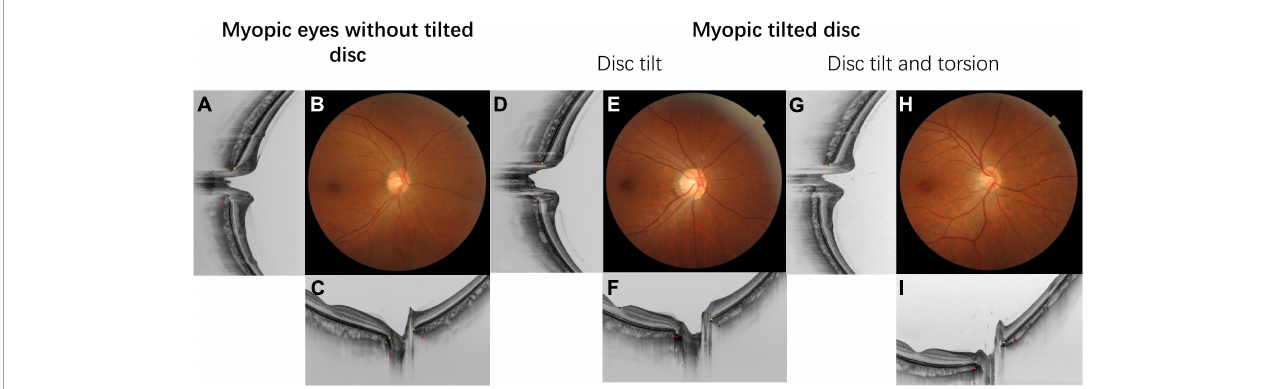
FIGURE1 This figure demonstrated the fundus photograph and its corresponding horizontal and vertical cross-sectional optical coherence tomography (OCT) scan. The Bruch’s membrane openings are marked with green dots and the anterior scleral openings are marked with red dots. Details of the ovality index and disc torsion angle measurement are provided in Figure 3 . (A–C) Fundus photograph and OCT scan of myopic eyes without tilted disc. (D–F) Myopic tilted disc with ovality index = 1.34 with disc torsion angle = 0. (G–I) Myopic tilted disc with ovality index = 1.34 and disc torsion angle = 21.1 ◦